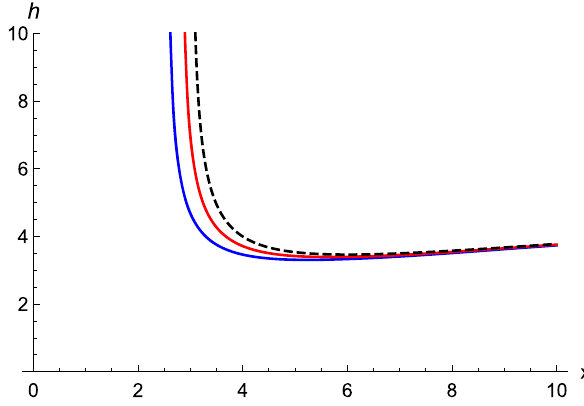
Fig. 4 The angular momentum ¯ h = h / M vs. x for several values of ˜ ξ = ξ/ M 2 . From left to right: ˜ ξ = ˜ ξ = 16 / 27 (blue), ˜ ξ = 0 . 3 (red). c The dashed curve corresponds to the classical case ˜ ξ = 0